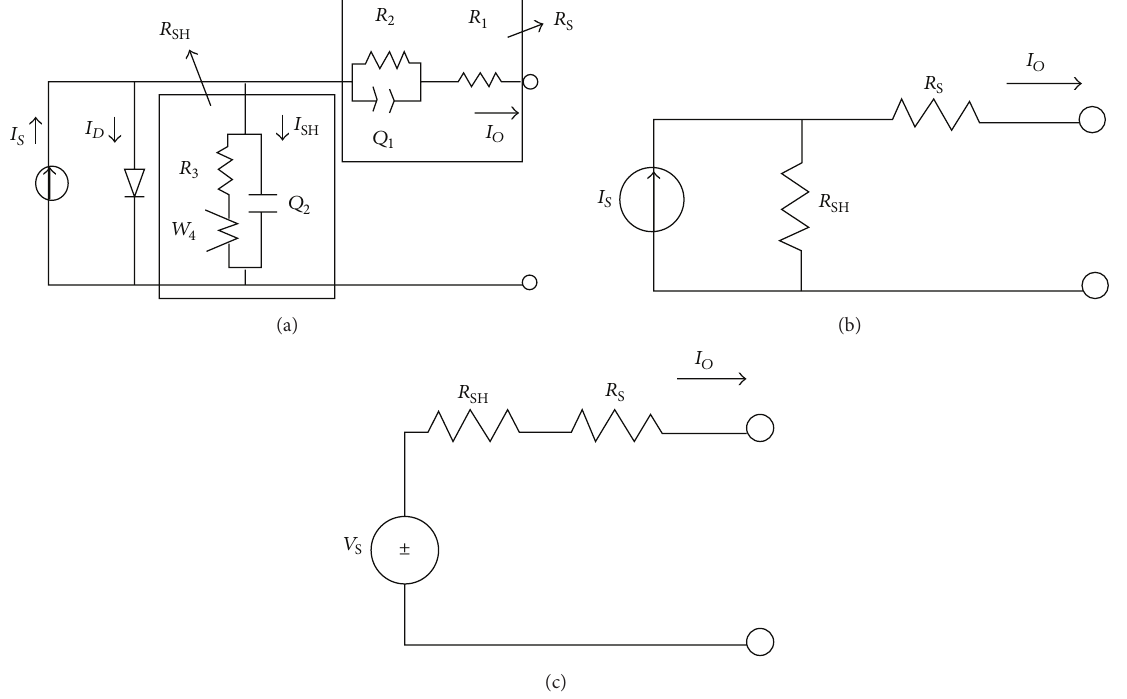
Figure 4: (a) Equivalent circuit of DSSC; simplified equivalent circuit of DSSC by (b) Norton’s equivalent circuit theorem; (c) Thevenin’s equivalent circuit theorem [1].